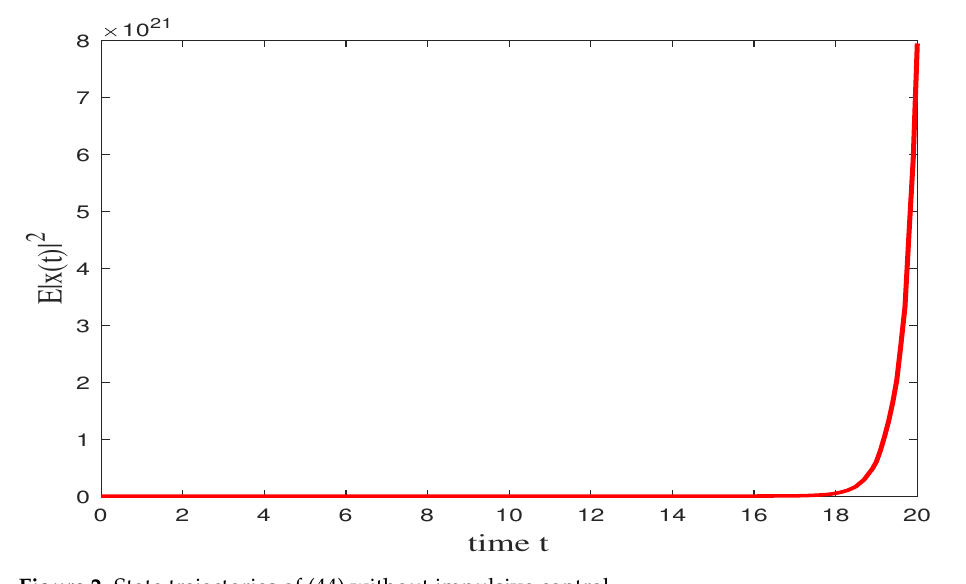
Figure 2. State trajectories of (44) without impulsive